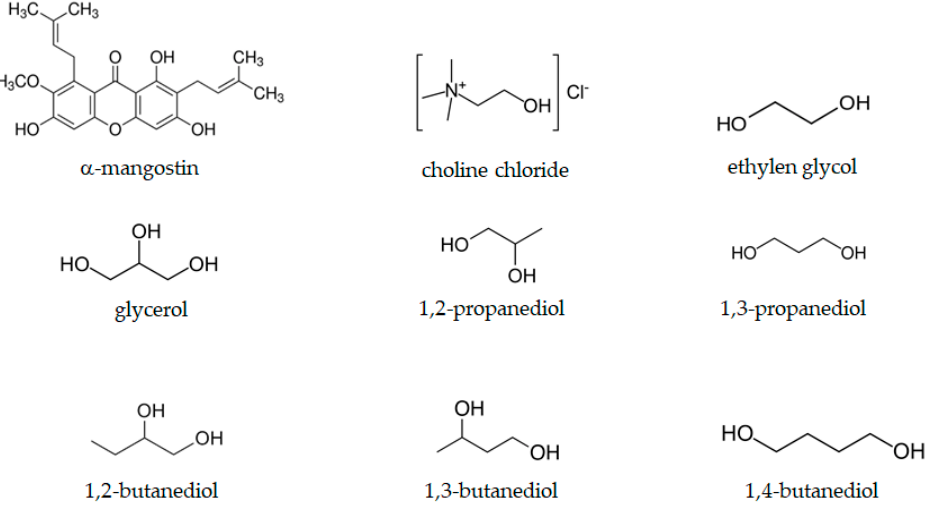
Figure 3. Chemical structure of α -mangostin, choline chloride, and polyalcohols used in this study.